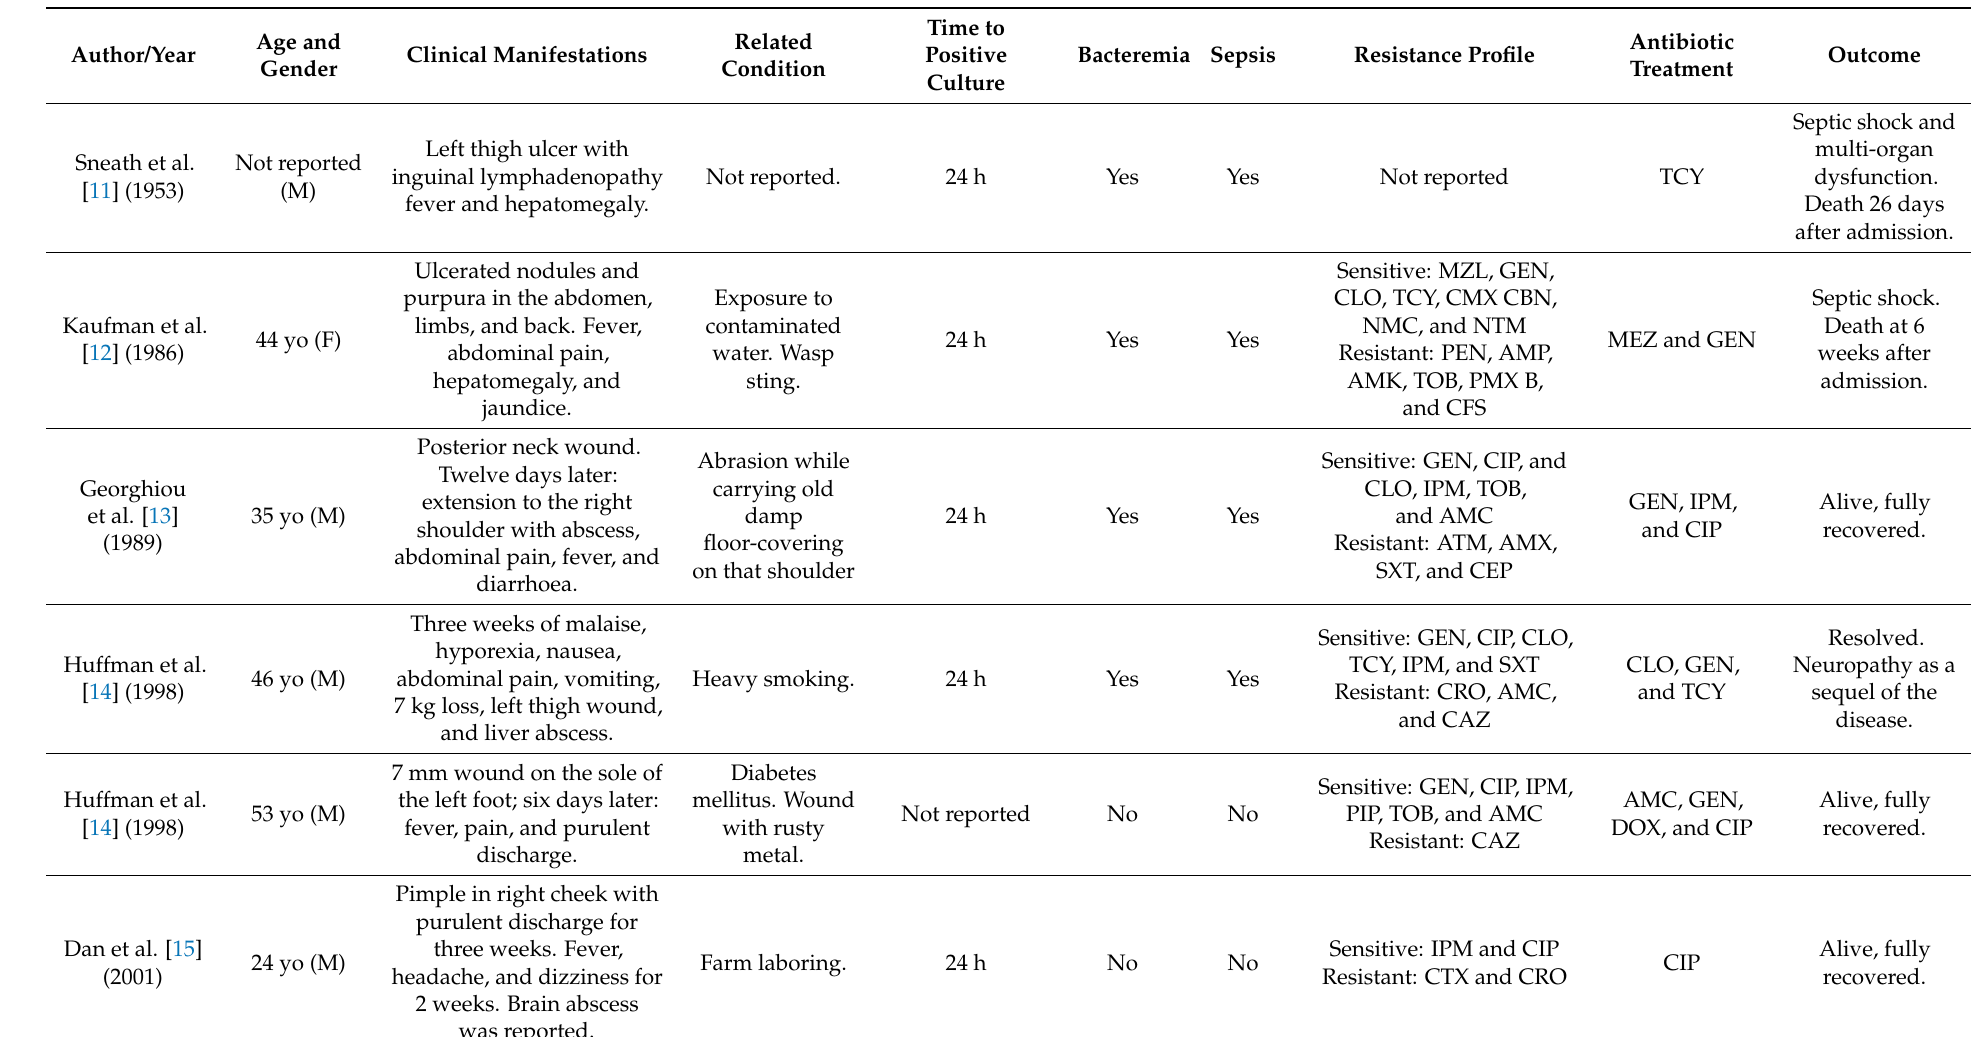
Table 2. Chromobacterium violaceum skin and soft tissue infections reported